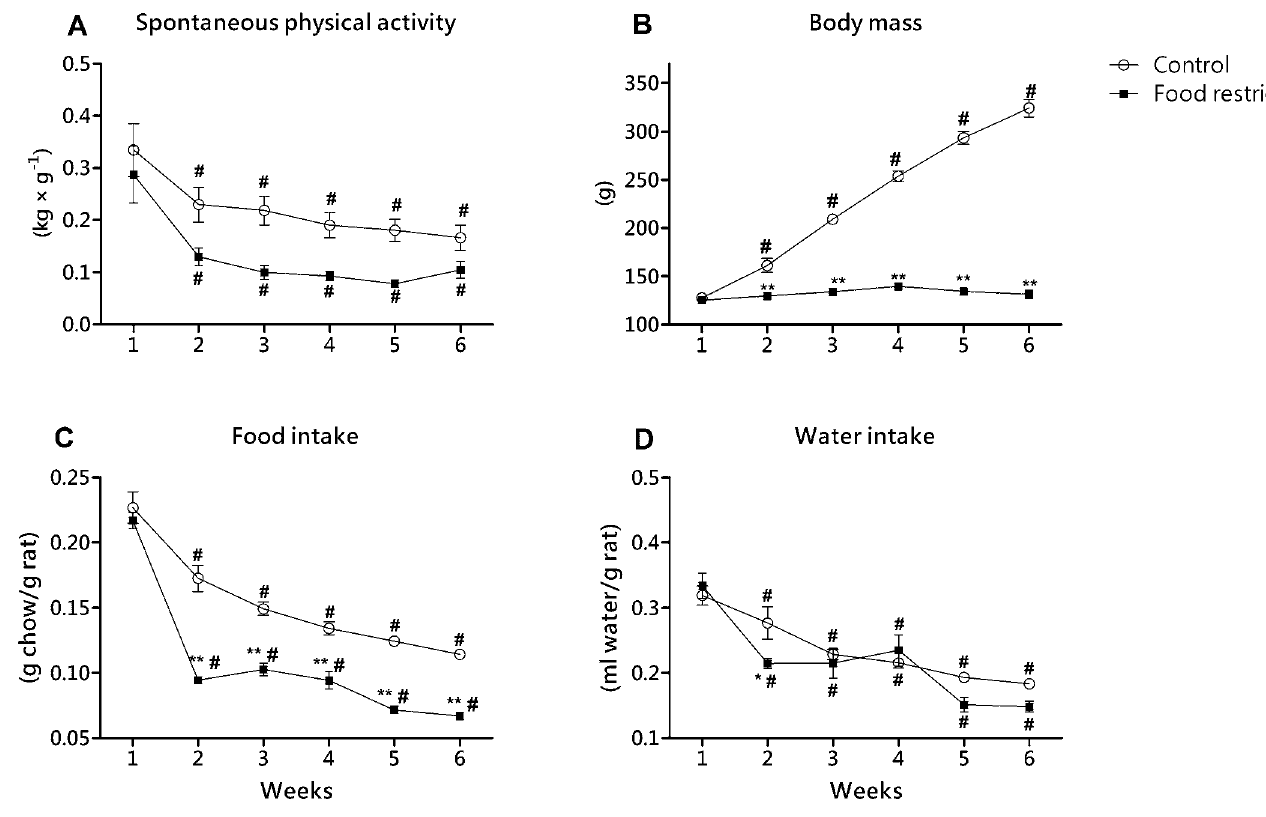
Figure 1. Data obtained during the six-week experiment for the control and food restriction groups; * P<0.05 in relation to control group to the same week; ** P<0.01 in relation to control group to the same week. # P<0.05 in relation to the first week for the same group. CG than FR (Figure 2A), whereas the relative brown adipose tissue showed no differences between groups (Figure 2B).